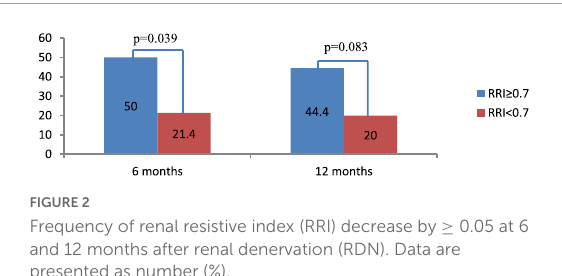
BP reduction of > 10 mmHg after 12 months (defined as a response). The number of drugs did not change (from 4.3 ± 1.0 to 4.3 ± 1.1, p = 0.811). The BP changes were significant and comparable in both groups during the follow-up period ( Figure 4 ). The decrease in RRI did not correlate with systolic BP reduction after RDN ( r = 0.05, p = 0.73 at 6 months; and r = 0.08, p = 0.59 at 12 months). According to multiple regression analysis ( Table 4 ) level of Hb1Ac had an independent effect on the RRI response to